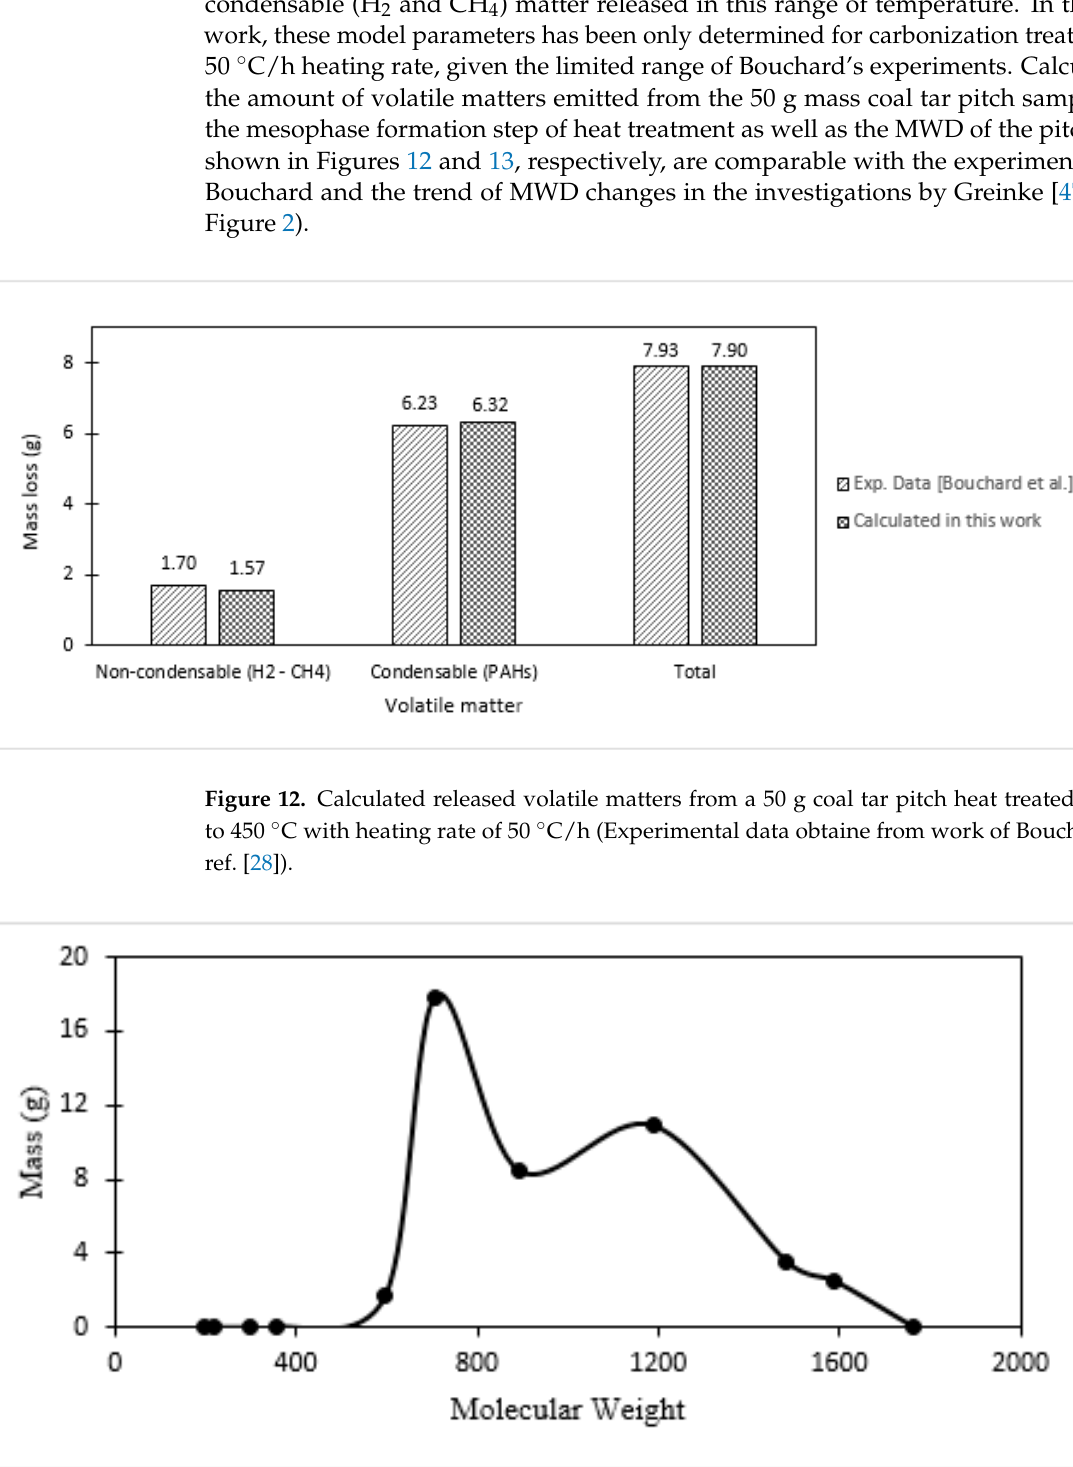
24 Figure 11. Estimated mass loss of anthracene, pyrene and chrysene versus temperature for different heating rates at carrier gas flow rate of 2300 cm 3 /min and ɸ (cid:3036) s = 1 ( a – c ) and with different values of ɸ i s parameters at a heating rate of 50 °C/h, carrier gas flow rate of 2300 cm 3 /min ( d – f ). Changing the ɸ (cid:3036) s values for each volatile species, as the extremely simple kinetic model parameter, to less than 1 (in the previous calculations) enables us to estimate the behavior of a system with conditions closer to the equilibrium state (Figure 11d–f). These figures show the variation of mass loss of three volatile compounds (e.g., anthracene,